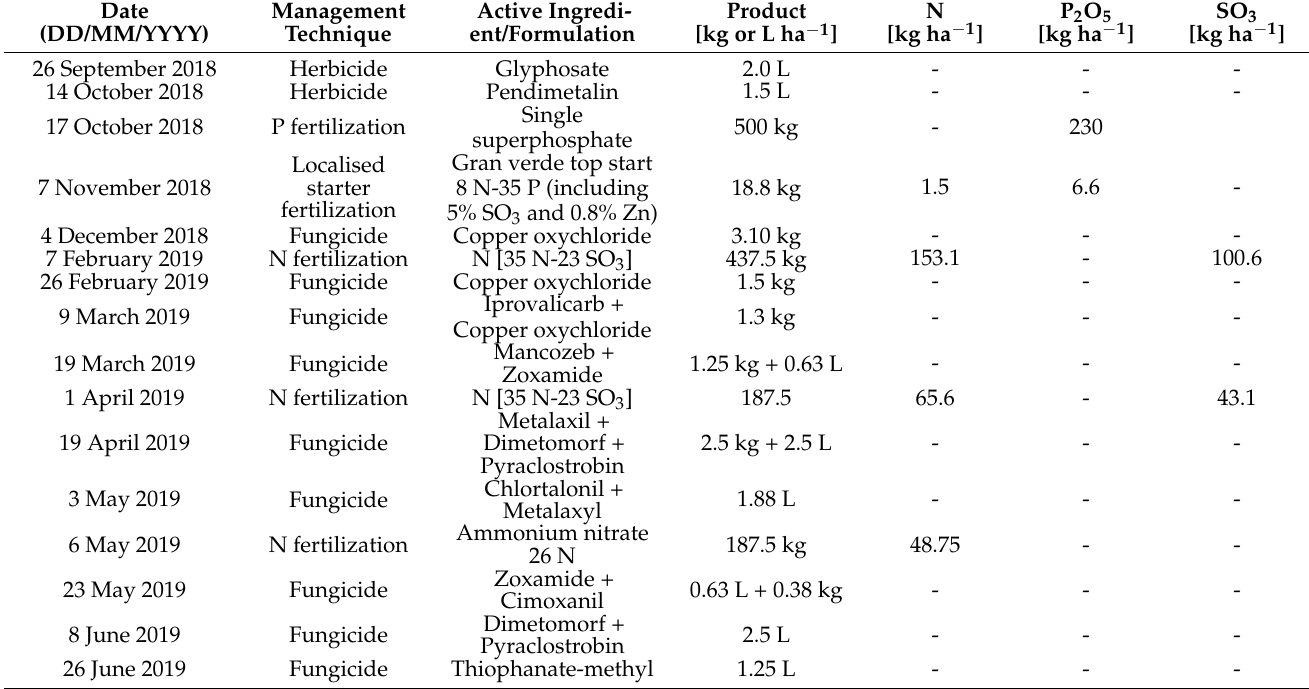
Table 1. List of the products (fertilizes and active ingredients) applied in the experimental onion field, along with date of application, number of products and, for the nutrients, amount of nutrients per unit area. The author does not endorse or sponsor any commercial product, service, or